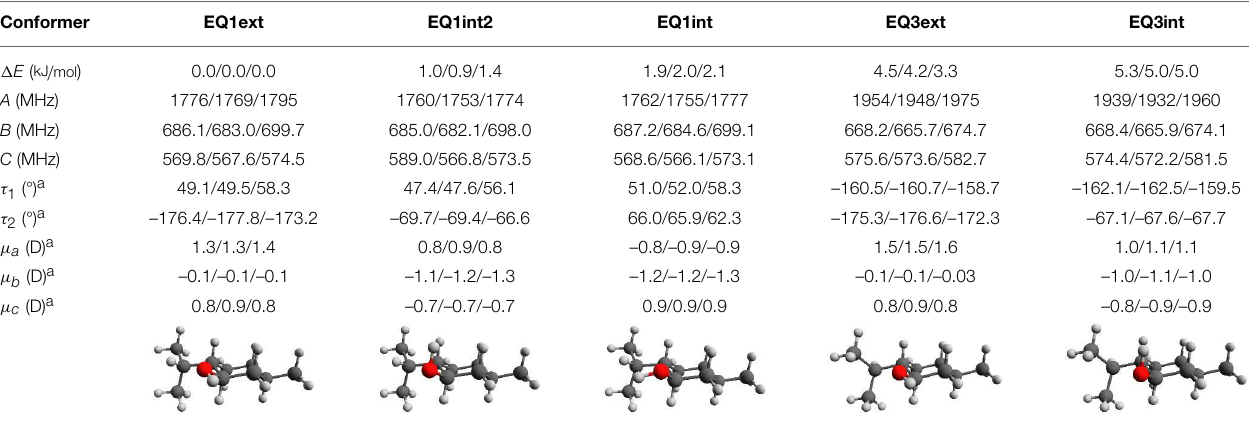
TABLE 2 | Calculated relative zero-point corrected energies, rotational constants, dipole moments, and torsional angles for the five lowest energy conformers of menthol.